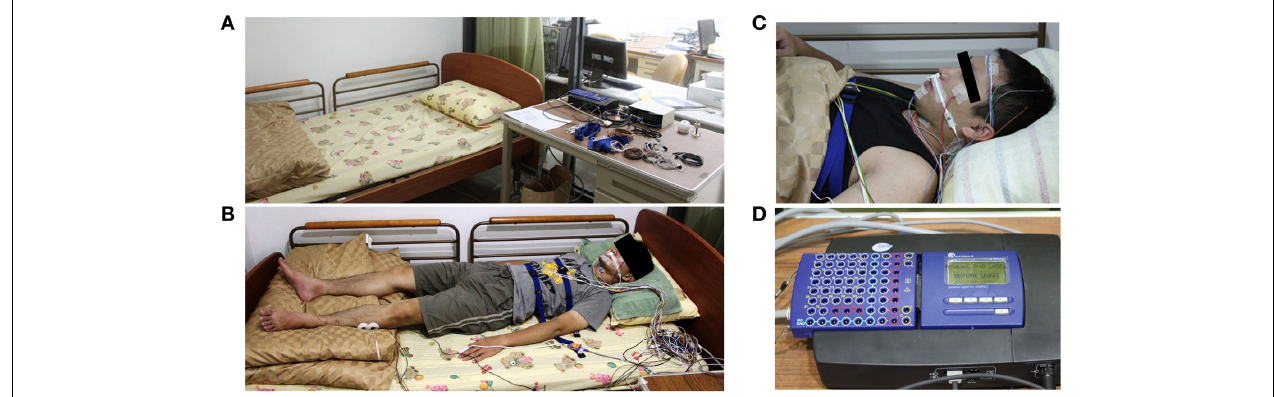
FIGURE 1 | Experimentenvironmentandthepolysomnographyrecording device (Holland et al., 1974). (A) The experiment environment in the sleep laboratory of National Chiao-Tung University. (B) The real situation with